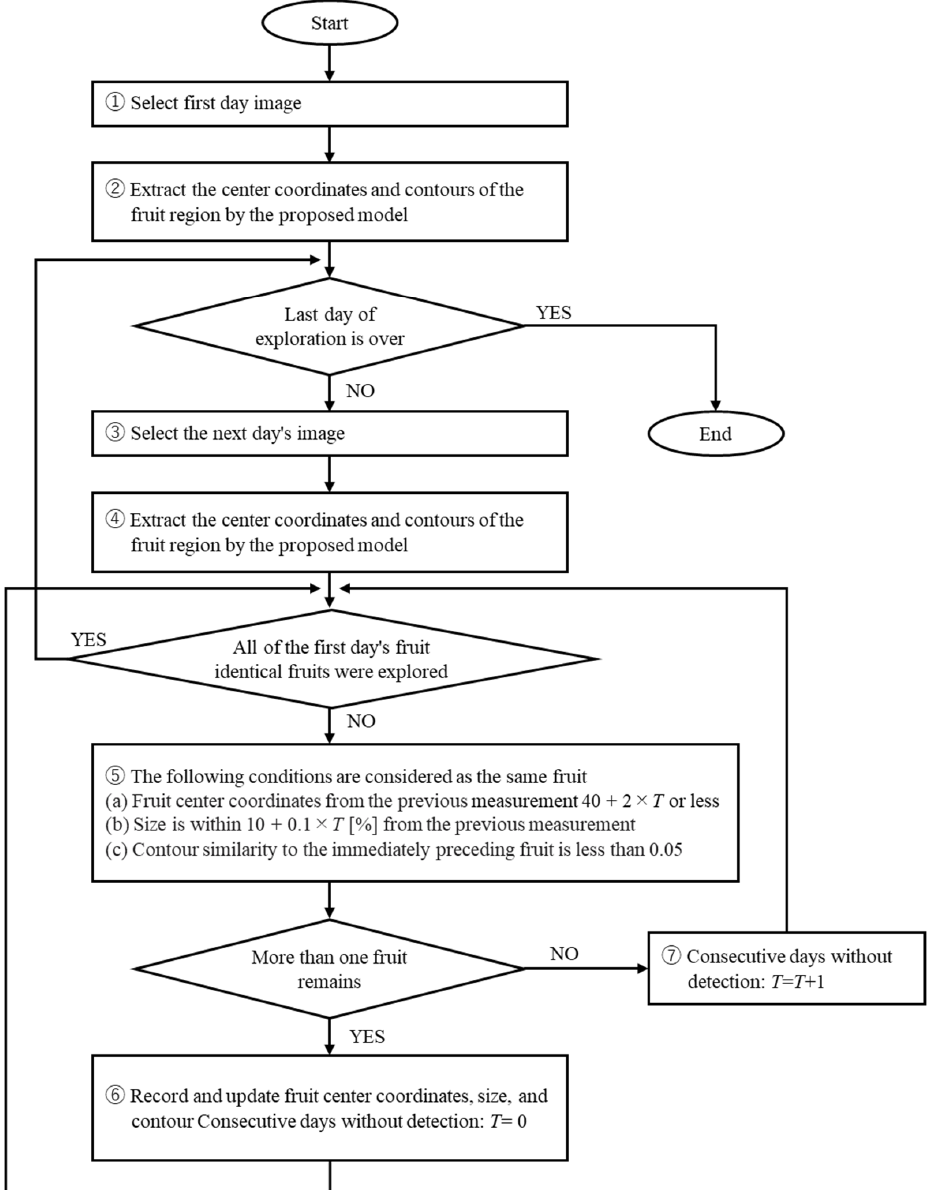
Figure 5. Flow chart of the fruit detection algorithm for tracking identical fruit in images captured at different dates and times on a farm. A three-layer filter was used to detect the same fruit at different times in part ⑤ : a distance filter, size filter, and contour filter. The distance filter considered the hanging range of the fruit position caused by an increase in weight due to fruit growth; the size filter considered size variation due to growth and depth movement; the contour filter excluded fruits with incorrect contours and non-identical fruits with similar positions and sizes by calculating the contour similarity. T is the number of non-detect days, and it increases when the identical fruit is not found to mitigate the limitations of the distance and size filters in the search for identical fruit on the following